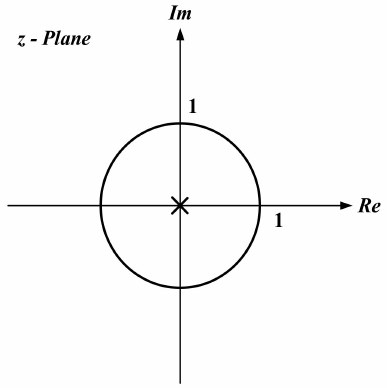
Figure 2. The z-plane for the deadbeat EEMF observer pole